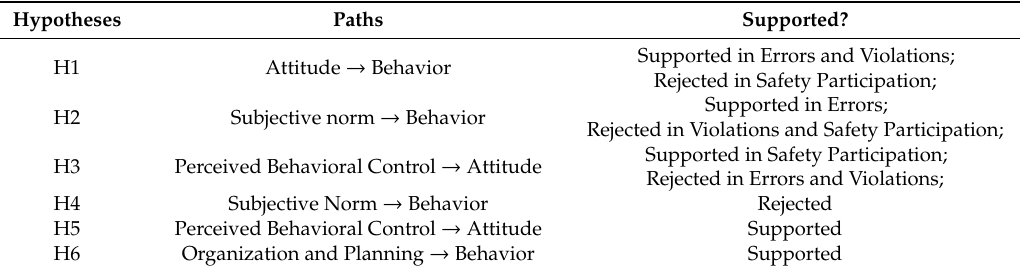
Table 3. Summary of the hypothesis test